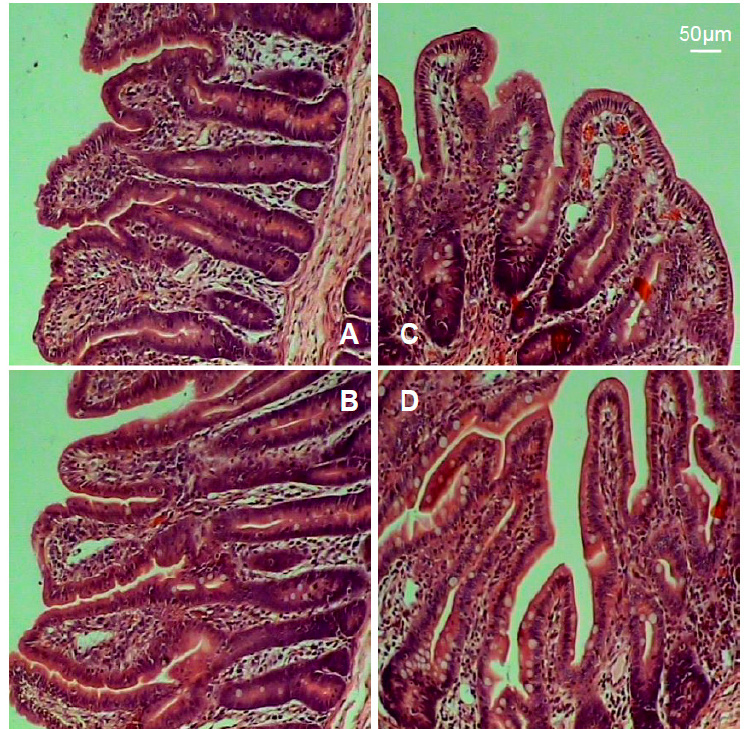
Figure 2. Intestinal mucosal morphology. ( A ) Jejunum (control). ( B ) Jejunum (TH group). ( C ) Ileum (control). ( D ) Ileum (TH group).